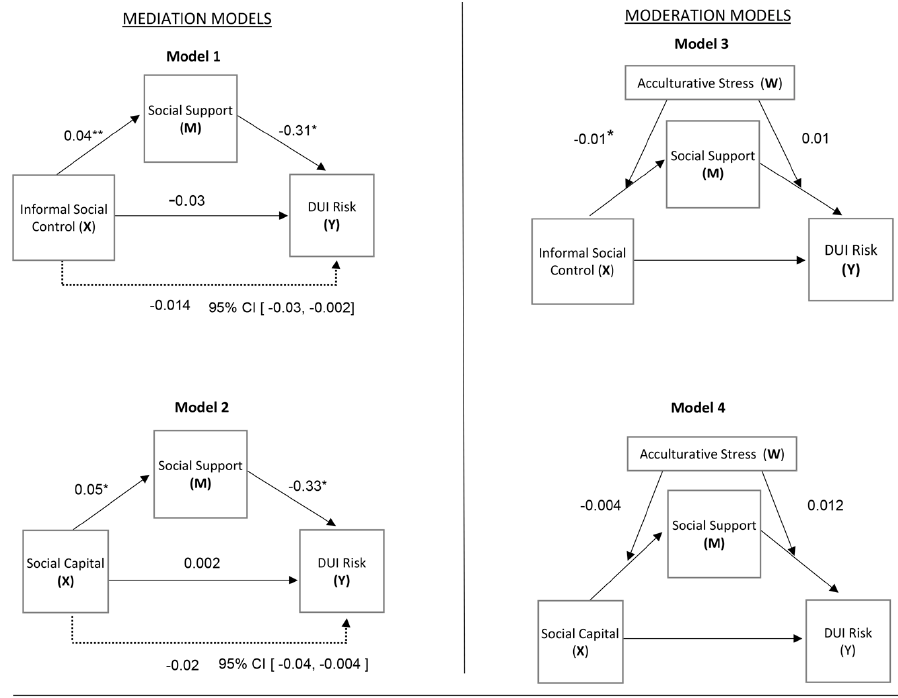
Figure 1. Results of tested mediation ( left panel ) and moderation ( right panel ) models; coefficients are provided in unstandardized values (b); * p < 0.05; ** p < 0.01; X: predictor; Y: outcome; M: mediator; W: moderator.